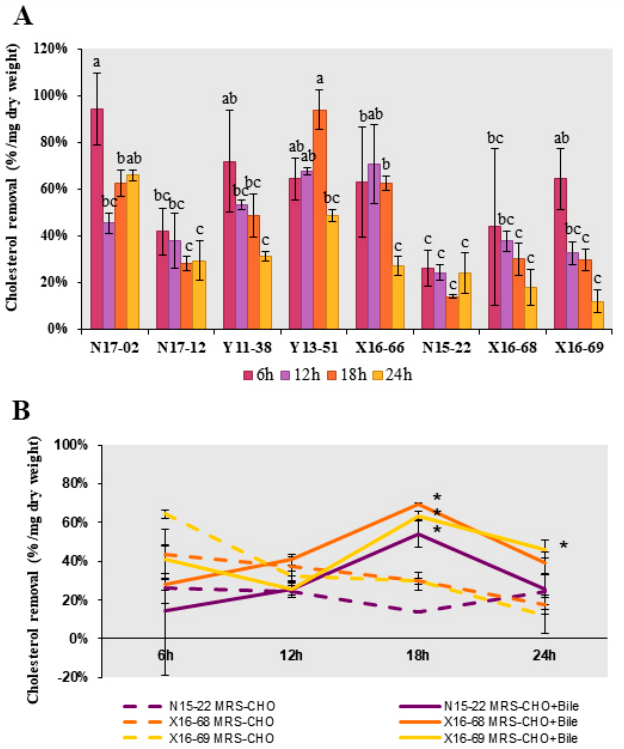
Figure 3. Cholesterol removal capability of the probiotic strains. ( A ). Cholesterol removal capability after incubation in cholesterol medium for 6 h, 12 h, 18 h and 24 h. Different superscripts (a–c) represent significantly different values ( p < 0.05). ( B ). Cholesterol removal capability by Lactobacillus strains N15-22, X16-68, and X16-69 in MRS containing cholesterol (MRS-CHO) with or without bile salt. Values are expressed as mean ± SE ( n = 3). The asterisk indicated the significantly different values ( p < 0.05) between the mediums with or without bile salt for the same strain.